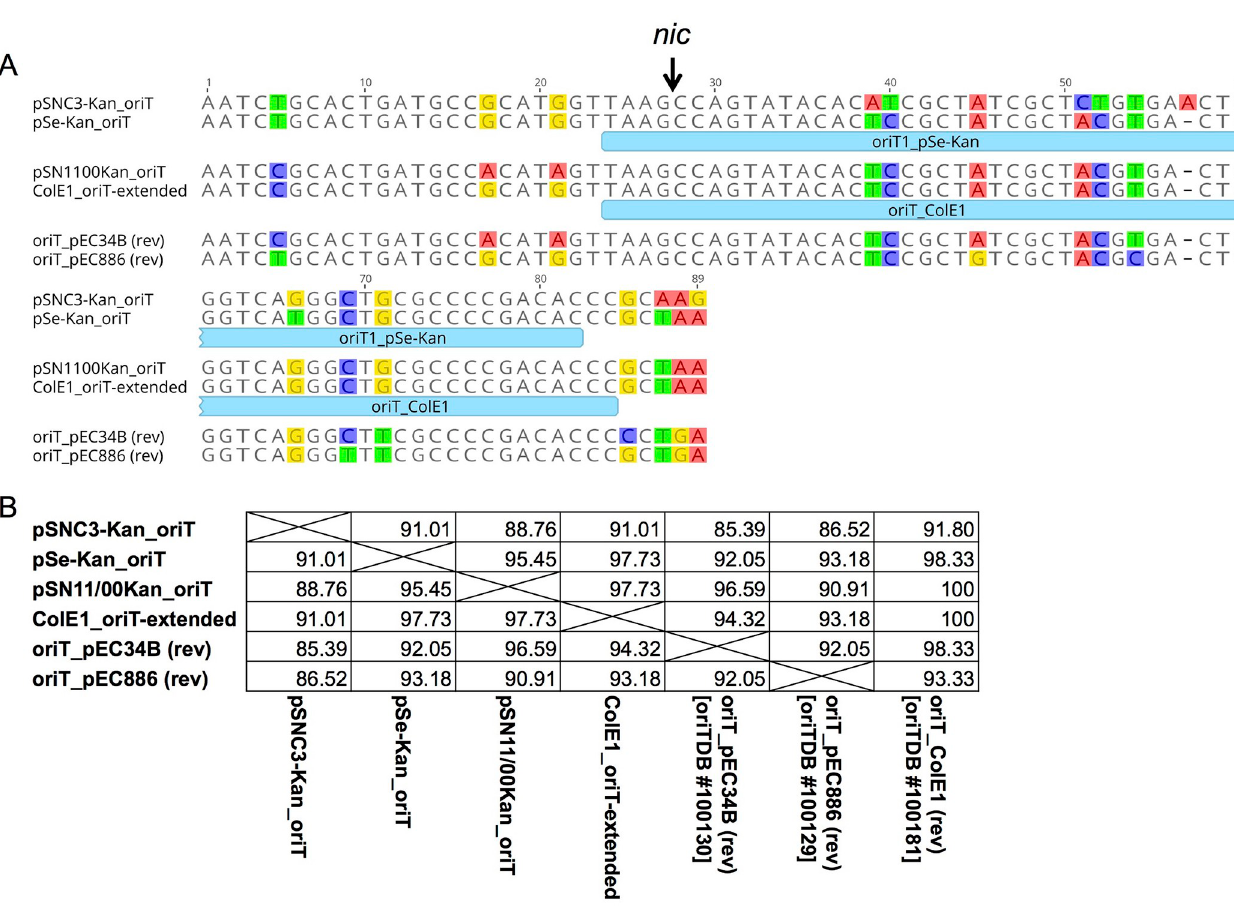
PLOS ONE | https://doi.org/10.1371/journal.pone.0268502 July 14,